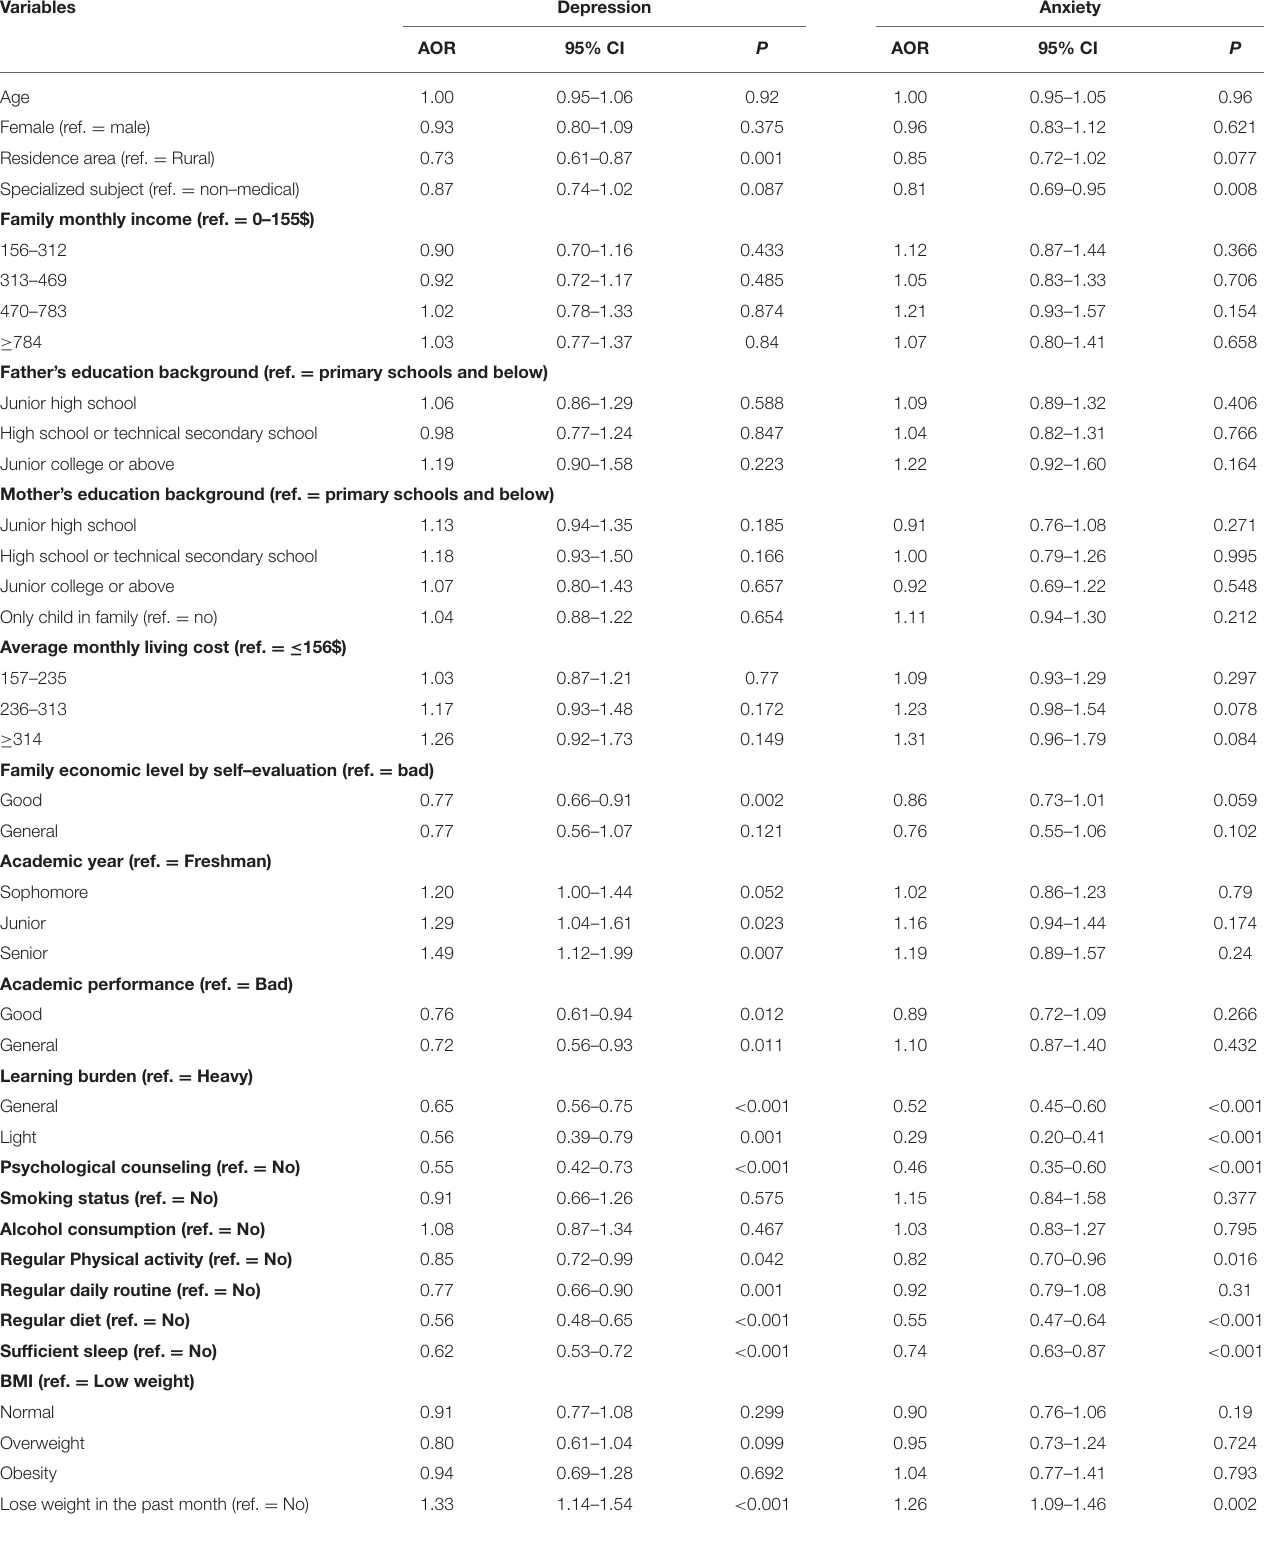
TABLE 3 | Multivariate logistic regression of anxiety and depression. Variables